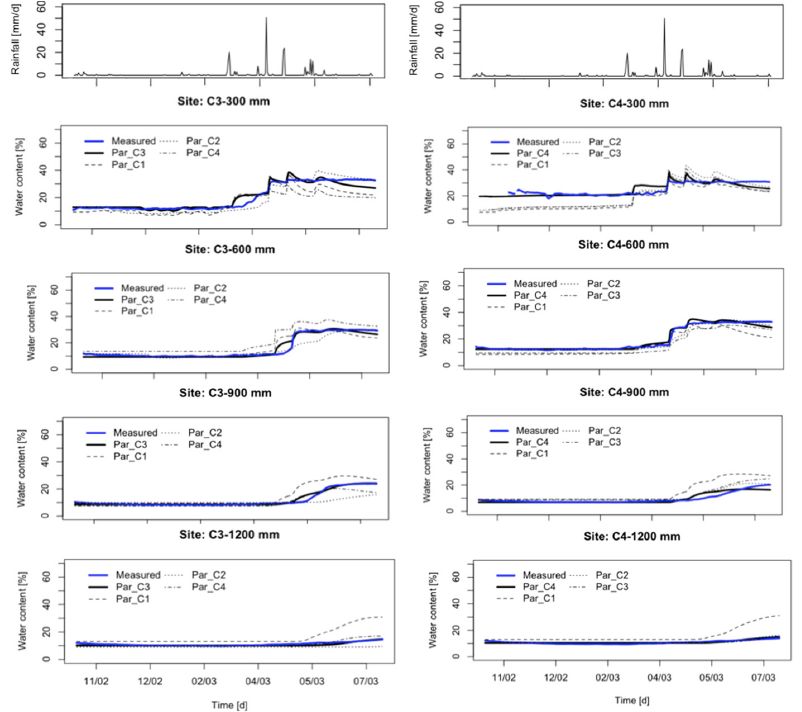
Figure 6. Soil moisture dynamics at different depths (300, 600, 900 and 1200 mm) in locations C3 and C4. The blue bold lines are the measured data. The black lines are simulated SM values computed by using different parameters set (Par_C1, Par_C2, Par_C3, and Par_C4) as specified in the legend.